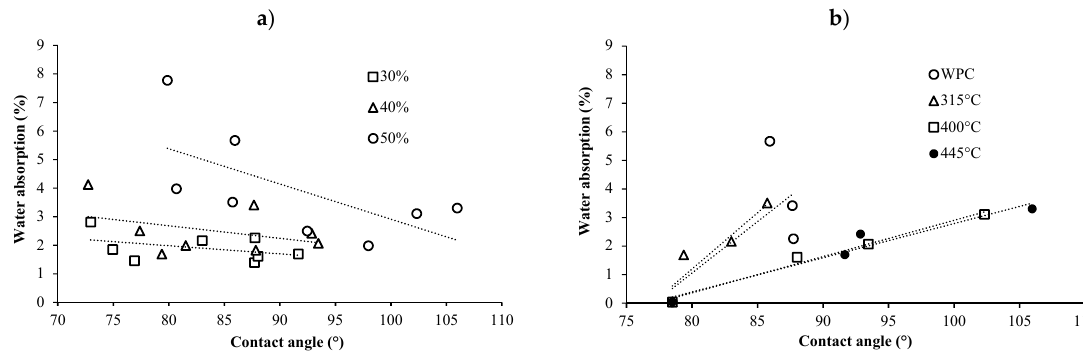
Figure 9. (a ) Relationship between water uptake and contact angle for composites made at di ff erent filler content (30 − 50%), and ( b ) relationship between water uptake and contact angle for biochar composites made at di ff erent pyrolysis temperature (315 − 445 ◦